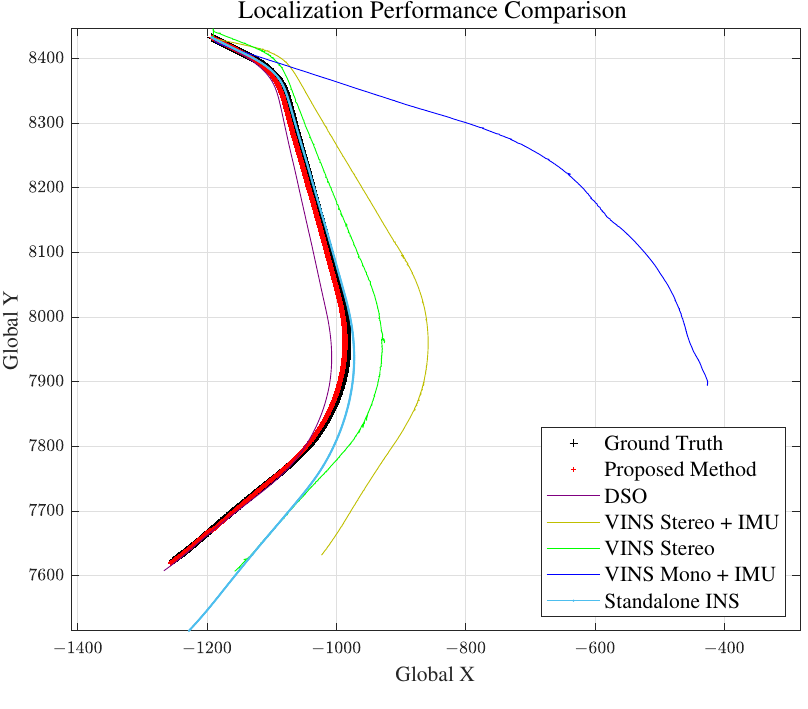
Figure 12. Scenario 1: Vehicle Localization with Various Methods.